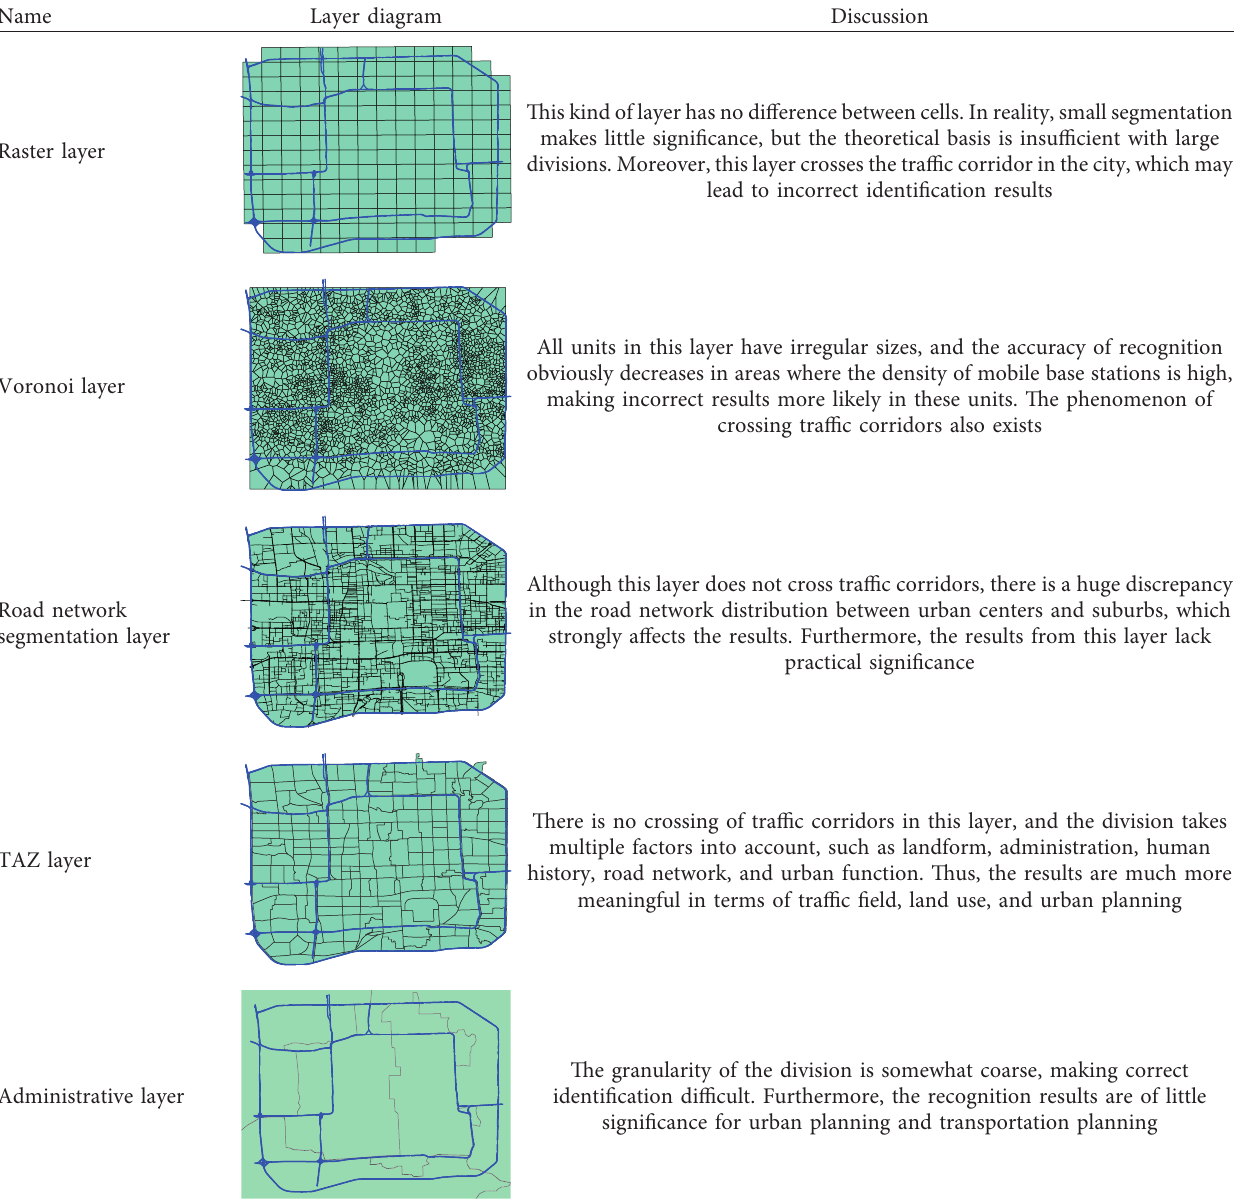
Table 3: Discussion of five